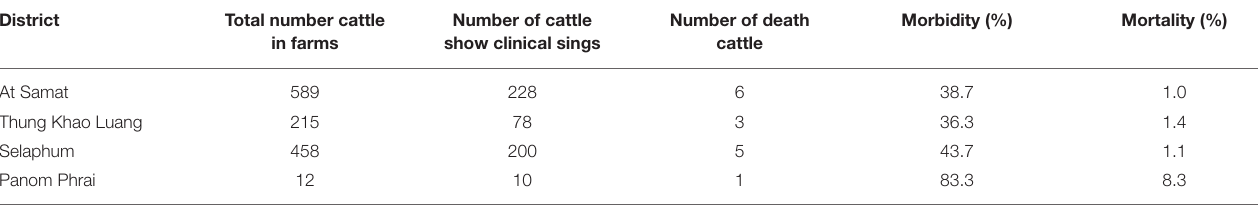
Number of cattle Number of death Morbidity (%) Mortality (%) in farms show clinical sings cattle